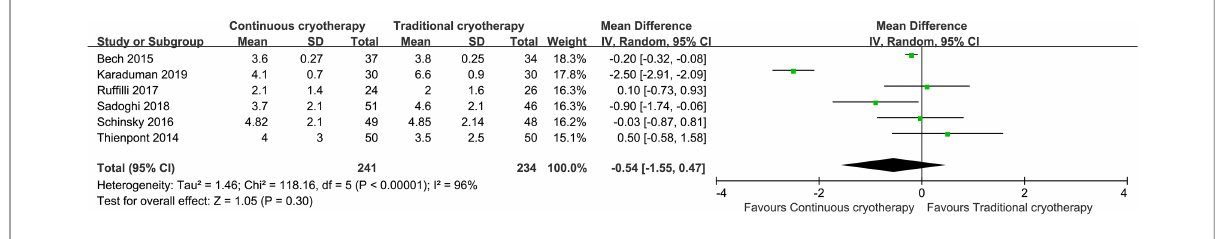
FIGURE 4 Forest plot for pain intensity.